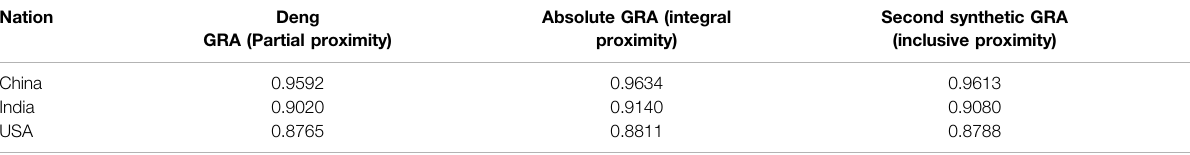
TABLE 4 | Grey relational assessment for fossil fuel consumption and CO 2 emission.